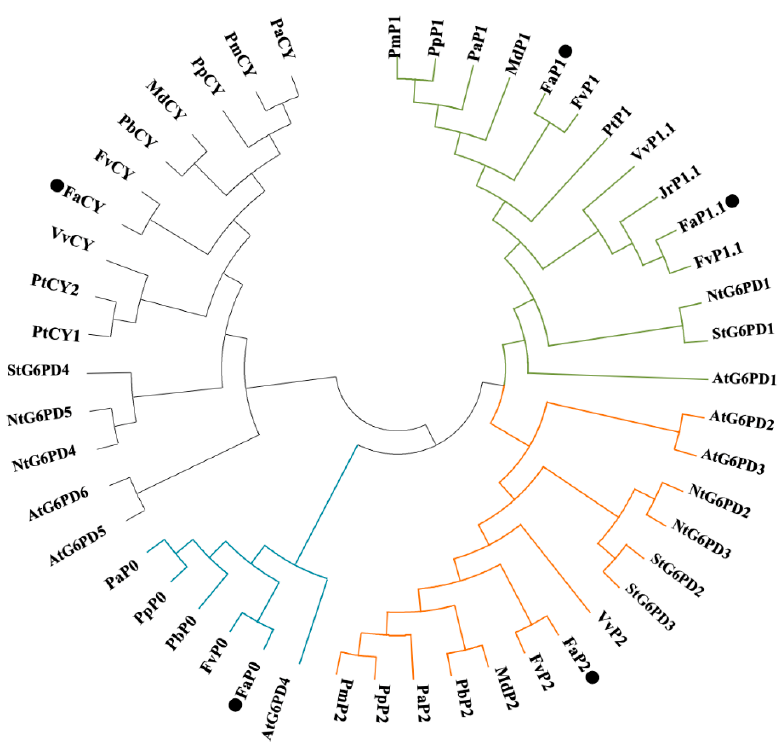
Figure 1. Phylogenetic analysis of G6PDHs from different species. Fa, Fragaria×ananassa (black